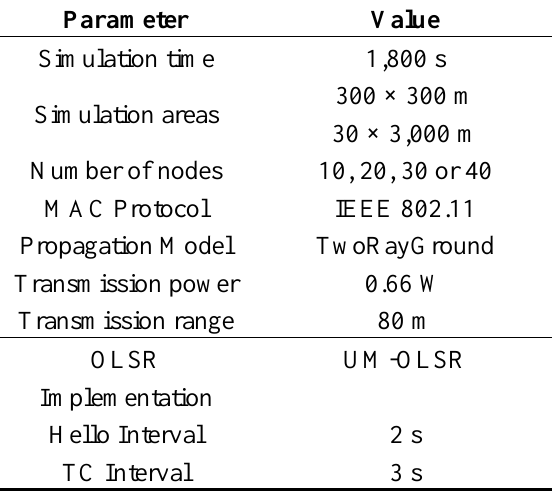
Table 1. Simulation parameters.